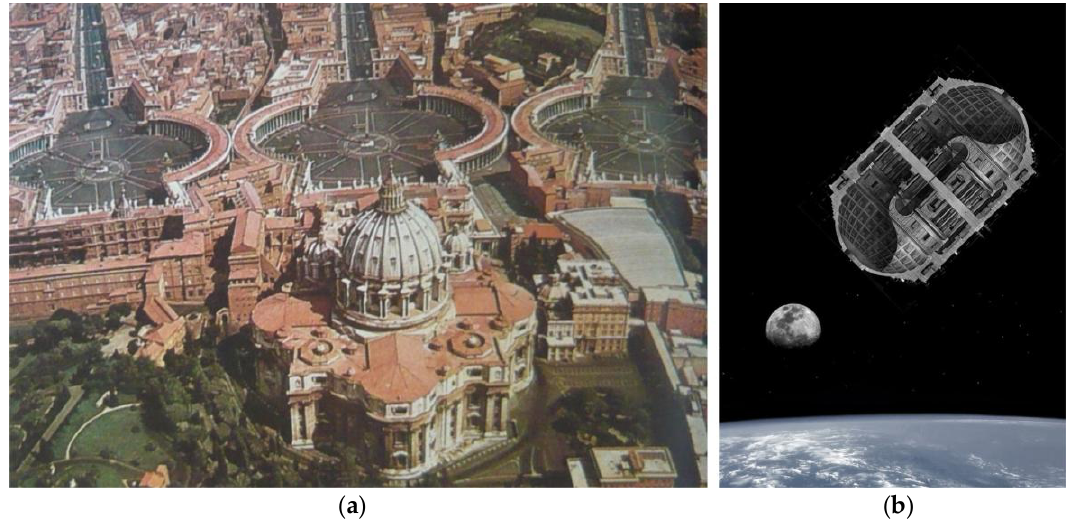
Figure 1. ( a ) Hans Dieter Schaal, Roma Arch-collages , 1977; ( b ) Luca Galofaro, Stazione spaziale – Ritorni , 2010.